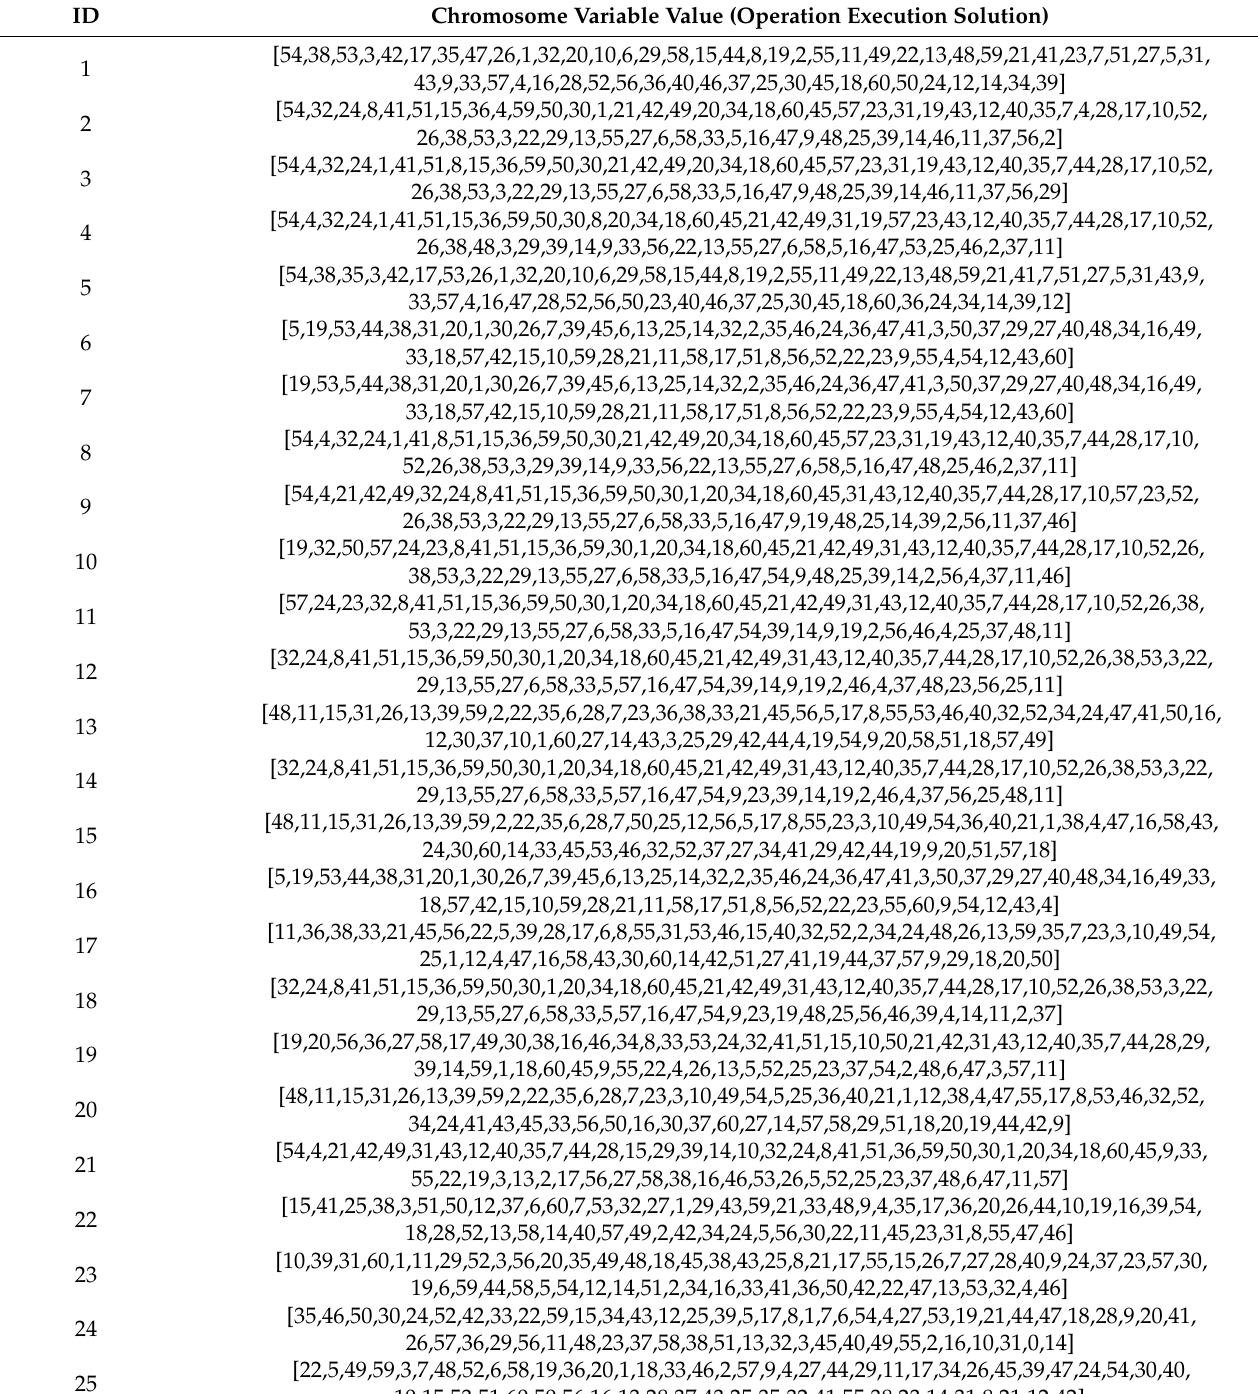
Table 6. Detailed execution solutions for non-dominated